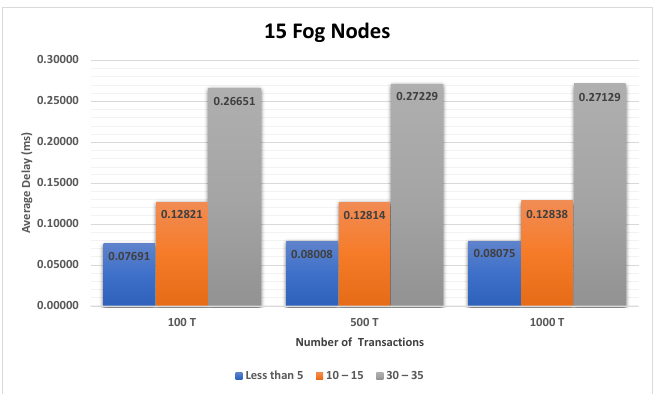
Figure A2. The impact of the different sets of affected transactions on 10 fog nodes.